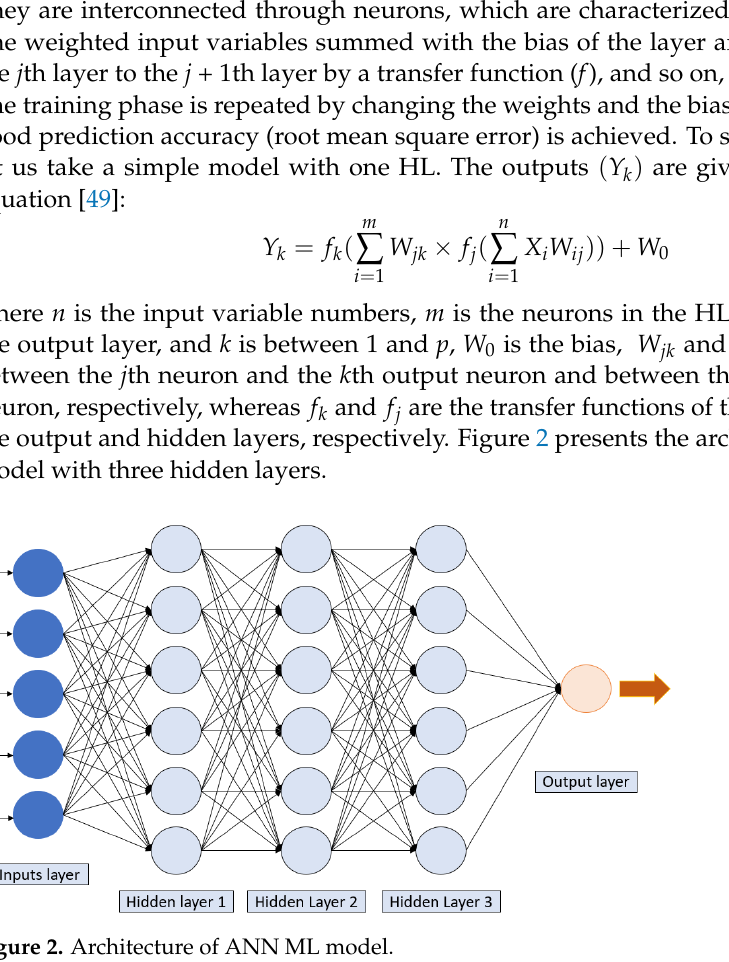
Figure 3. Flowchart of the adopted methodology.